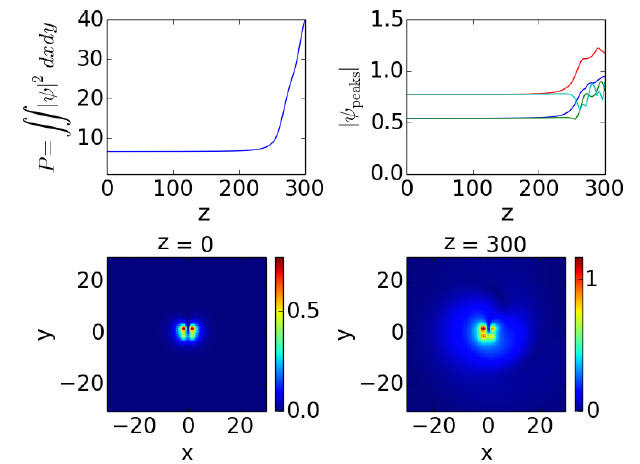
Figure 8. This figure is similar to Figure 5 (with an evolution up to distance z = 300). Here, the plots correspond to the evolution of the branch 2 solution for the value µ ≈ 0.244. In the top right plot, the colors follow the same pattern as in Figure 5 representing the four peaks. While the gain side of the solution seems to dominate, we also observe a quick increase in the spatial footprint of the solution. Shortly after the plotted time interval, the solution interferes with the boundary of the computed spatial